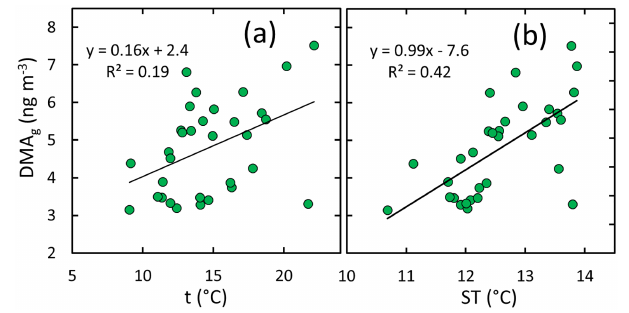
Figure 7. DMA in the gas phase vs. (a) air temperature and (b) soil temperature in